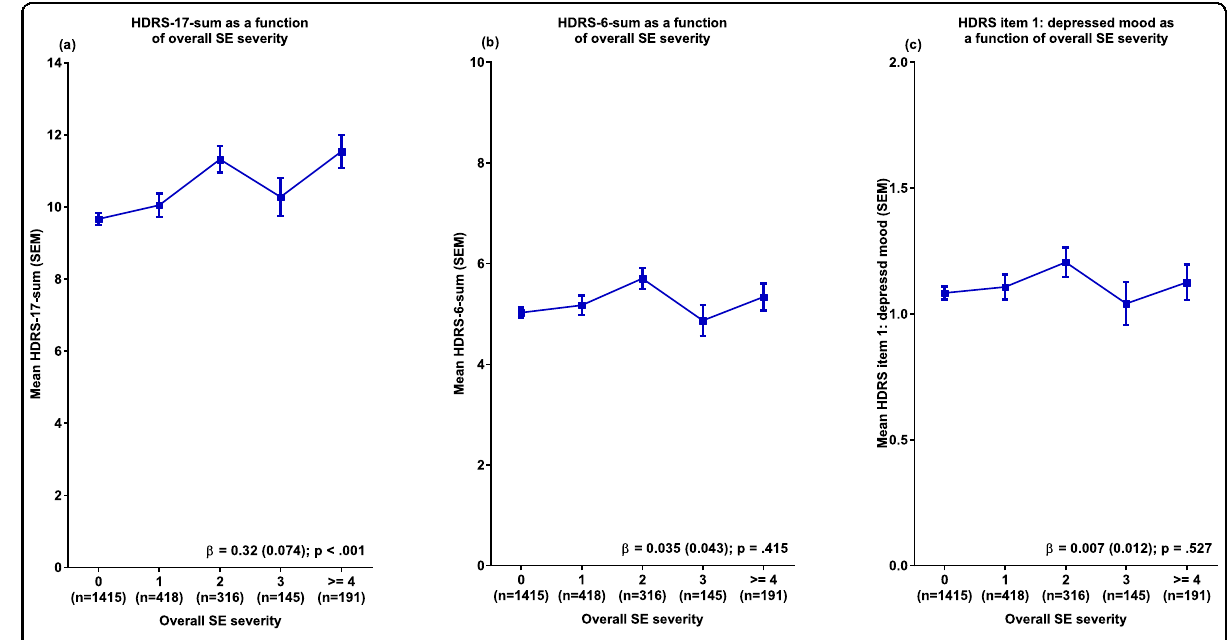
Fig. 2 Endpoint HDRS-17-sum, HDRS-6-sum and depressed mood ratings as a function of overall side effect (SE) severity. Side effect severities present in ≤ 50 patients have been collapsed for easier visualisation. β Beta coef fi cient (SEM) for the overall SE severity predictor, SEM standard error of the